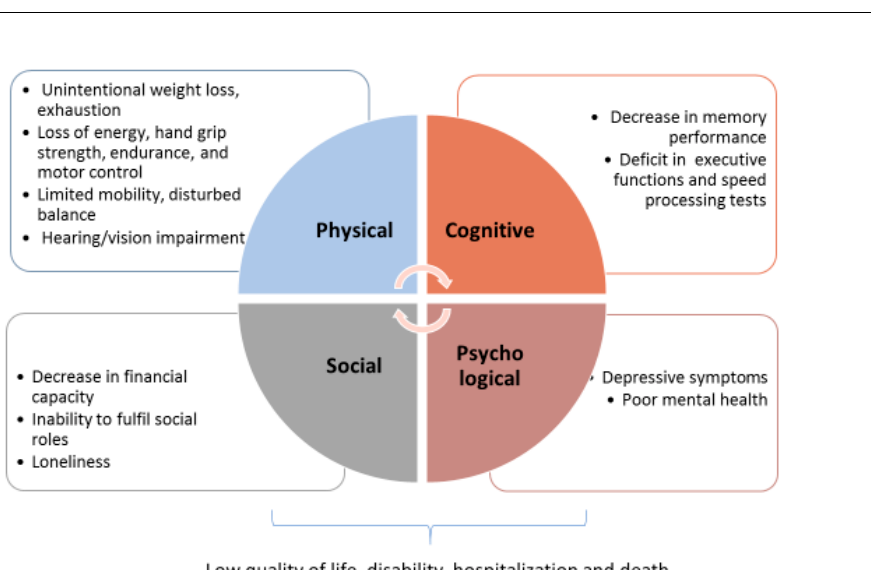
Figure 1. The multi-domain model of frailty.